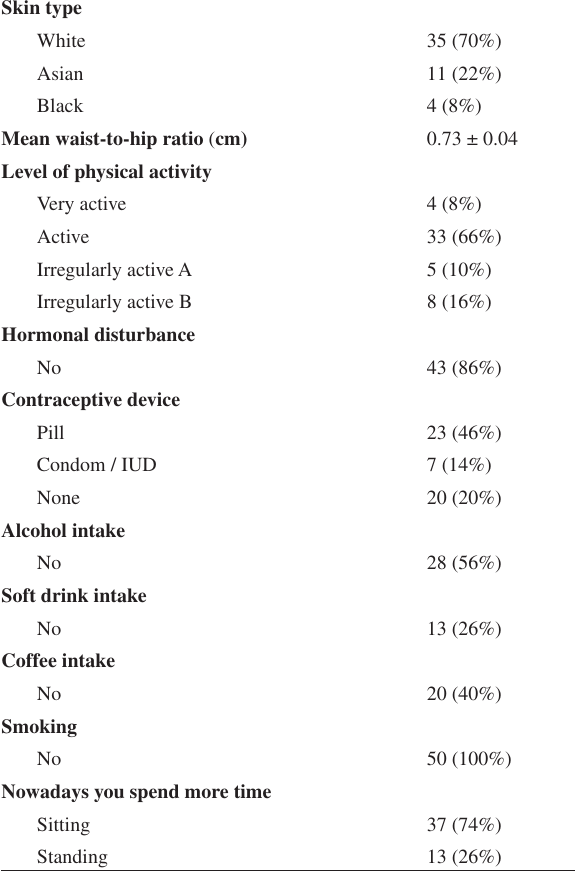
Table 2 - Characterization of the participant cohort Skin type